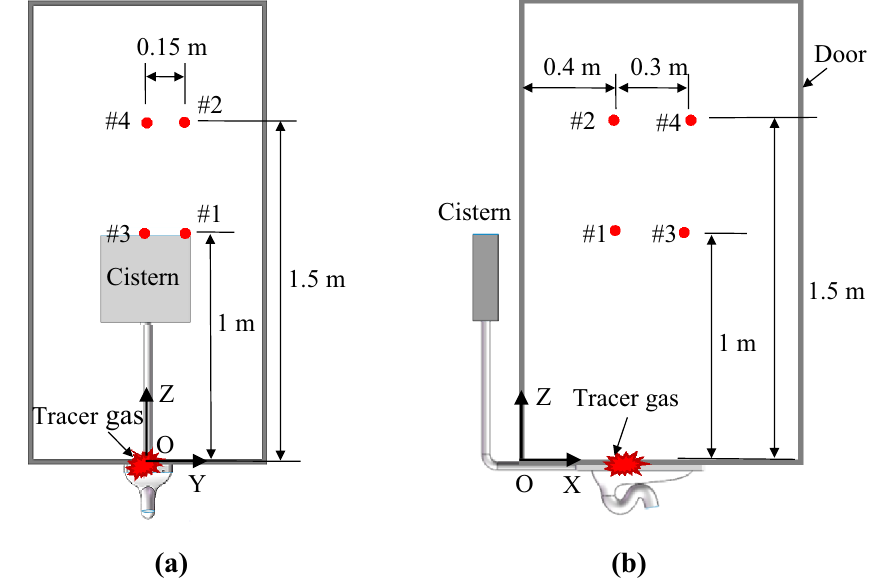
Figure 14. Sampling locations for the SF 6 tracer gas concentration: ( a ) front view, ( b ) side